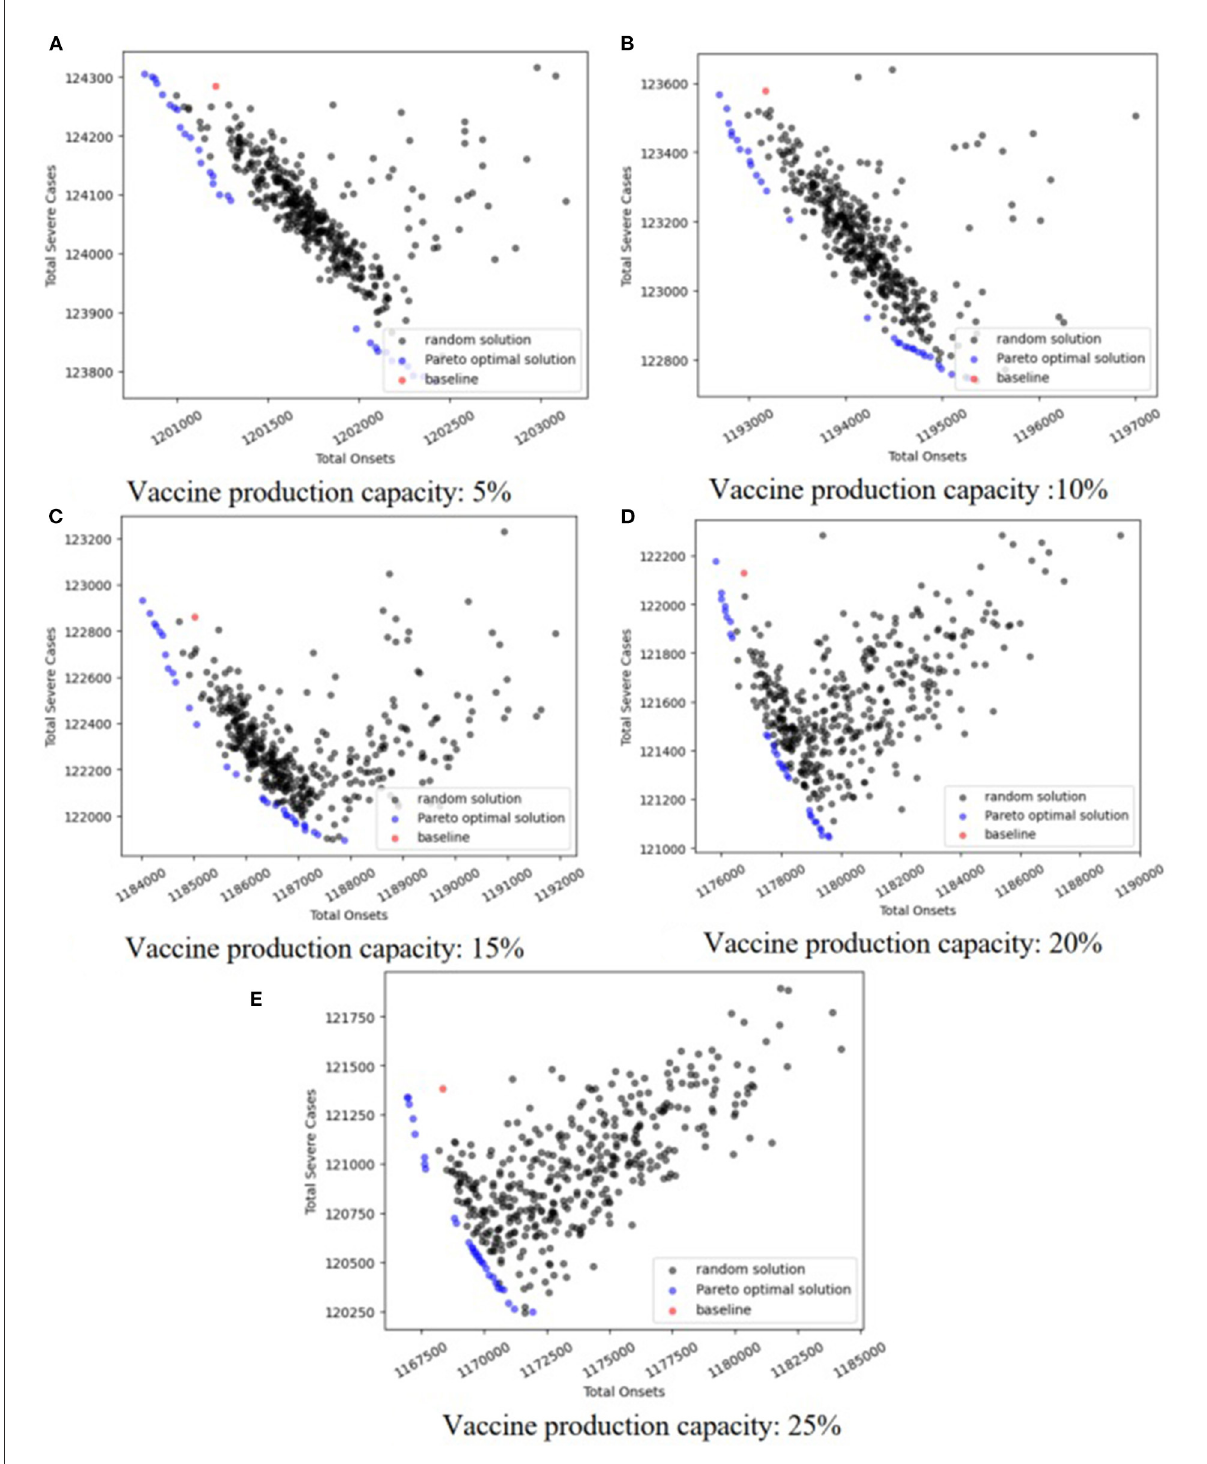
FIGURE4 Pareto optimal fronts when V e = 10 %